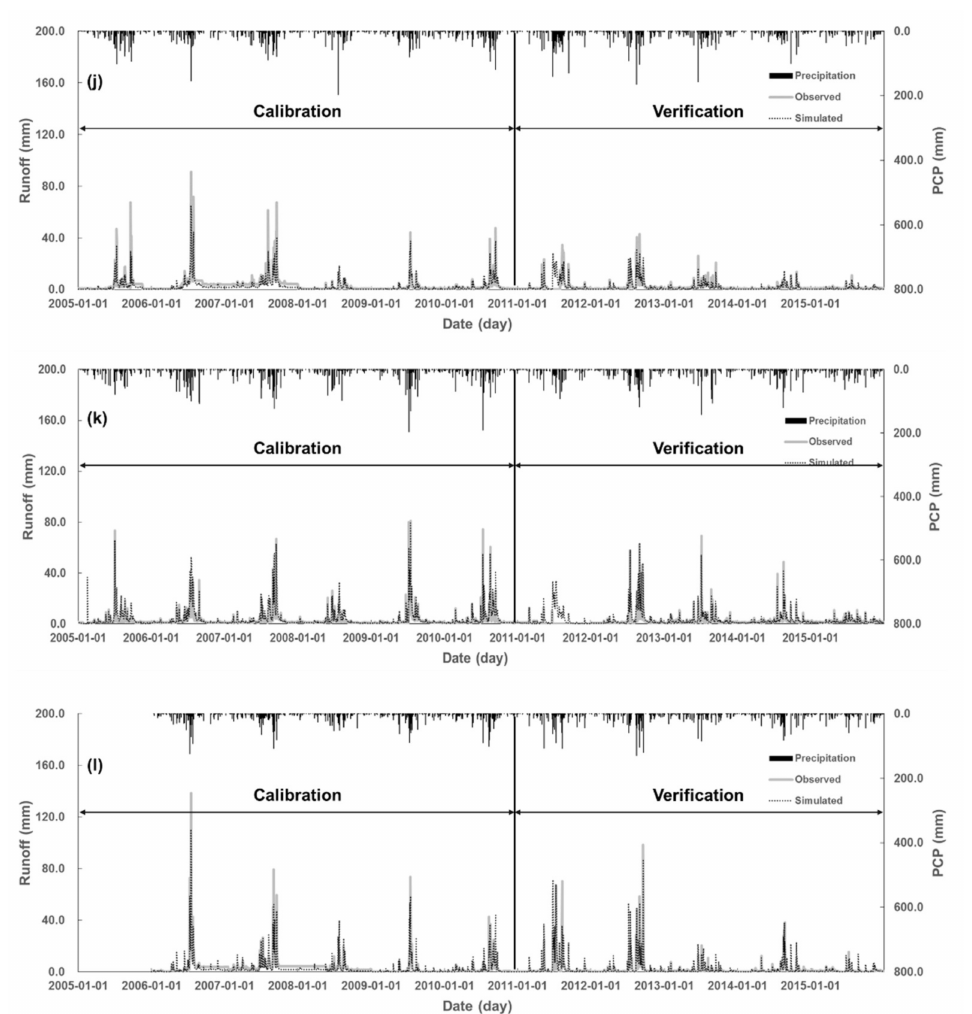
Figure 3. Comparison of the observed and DrySAT-WFT-simulated daily runoff during 2006–2015 at the ( a ) Chungju dam (CJ), ( b ) Soyanggang dam (SY), ( c ) Andong dam (AD), ( d ) Imha dam (IH), ( e ) Hapcheon dam (HC), ( f ) Seomjingang dam (SJ), ( g ) Osucheon dam (OSC), ( h ) Juam dam (JA), ( i ) Yongdam dam (YD), ( j ) Mihocheon dam (MHC), ( k ) Mareuk dam (MR), and ( l ) Chogang dam